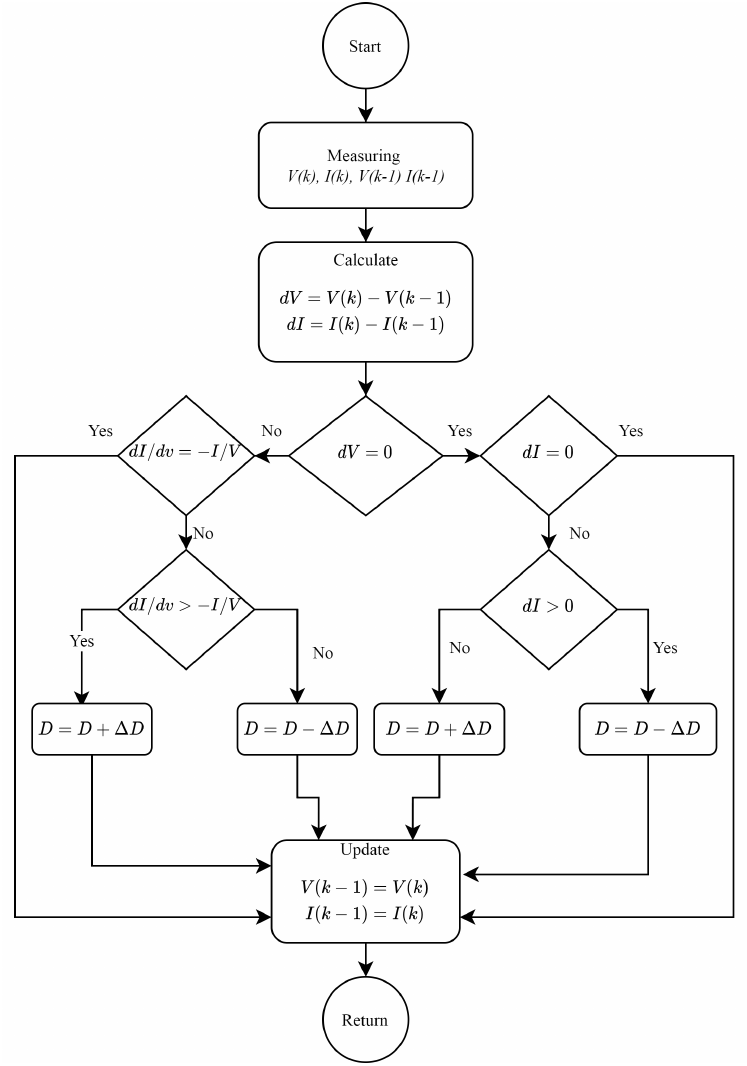
Figure 3. Flow chart of the InC MPPT